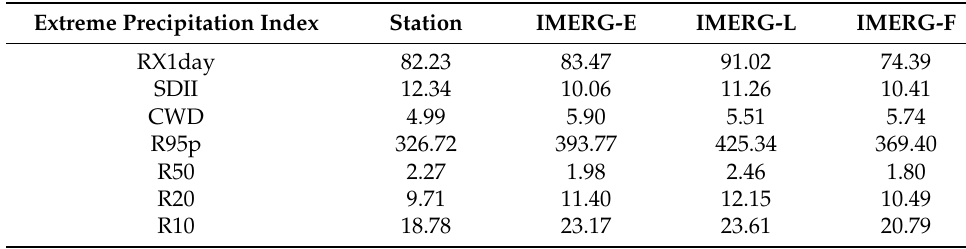
Table 6. Values of seven extreme precipitation indices derived from land station measurements and IMERG products.